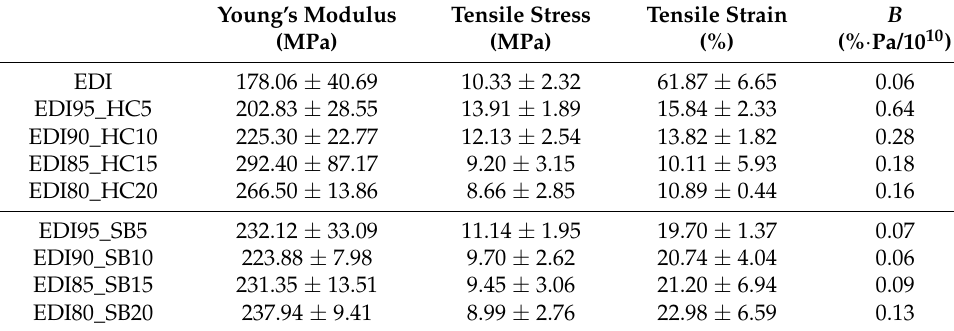
Figure 7. Stress–strain curves of the ( a ) ELO/HC-based composites and ( b ) ELO/SB-based composites. Table 3. Tensile test data and brittleness values of the samples.